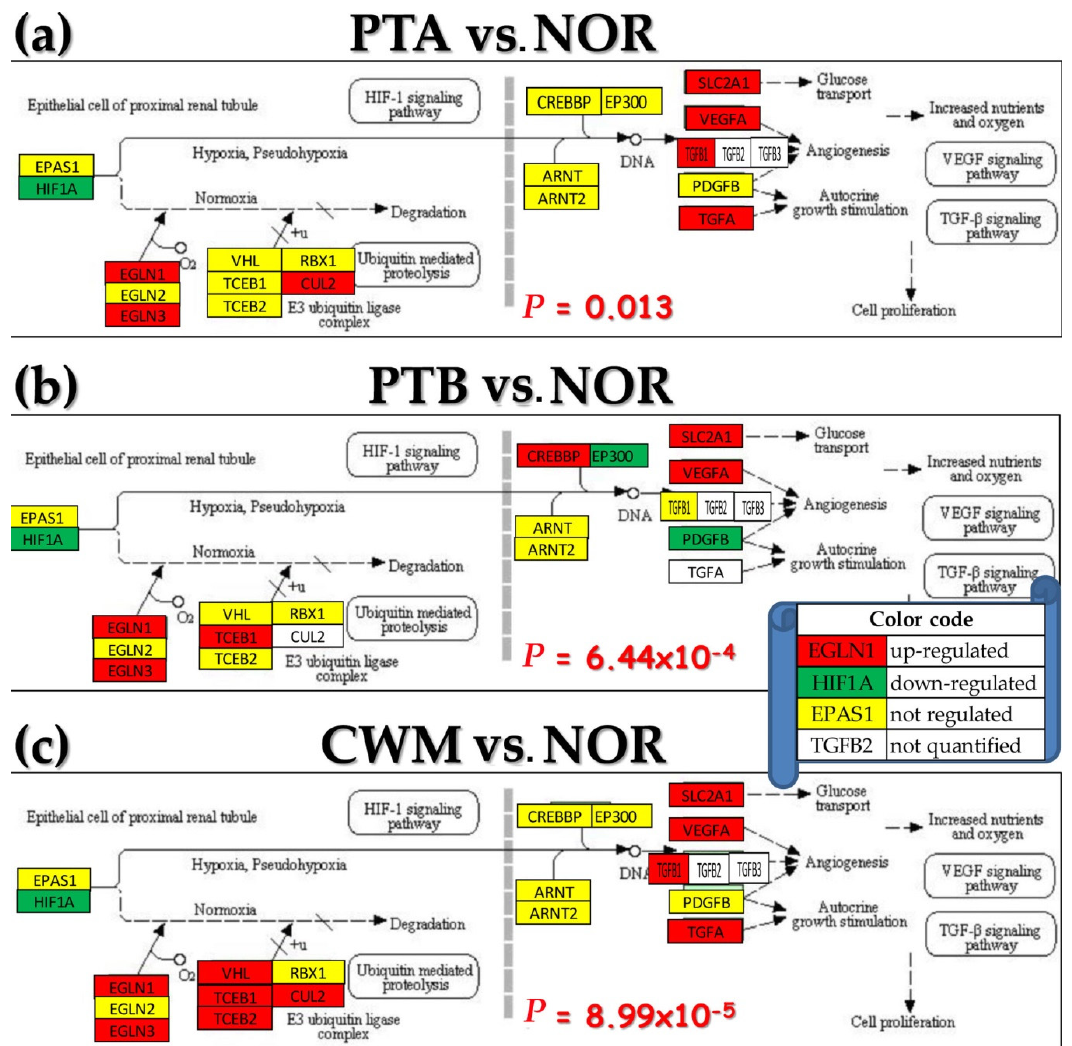
Figure 3. Regulation of the conventional Kyoto Encyclopedia of Genes and (KEGG)-determined ccRCC pathway in the three cancer nodules with respect to the normal tissue from the right kidney. ( a ) PTA vs. NOR; ( b ) PTB vs. NOR; ( c ) CWM vs. NOR Numbers are the p -values of the pathway overall regulation in the indicated comparisons. Significantly regulated genes: CREBBP (CREB-binding protein), CUL2 (cullin 2), EGLN1/3 (egl-9 family hypoxia-inducible factor 1/3), EP300 (E1A-binding protein p300), TCEB1/2 (transcription elongation factor B (SIII), polypeptide 1/2), TGFA/B1 (transforming growth factor alpha/beta 1), VEGFA (vascular endothelial growth factor A), and VHL.